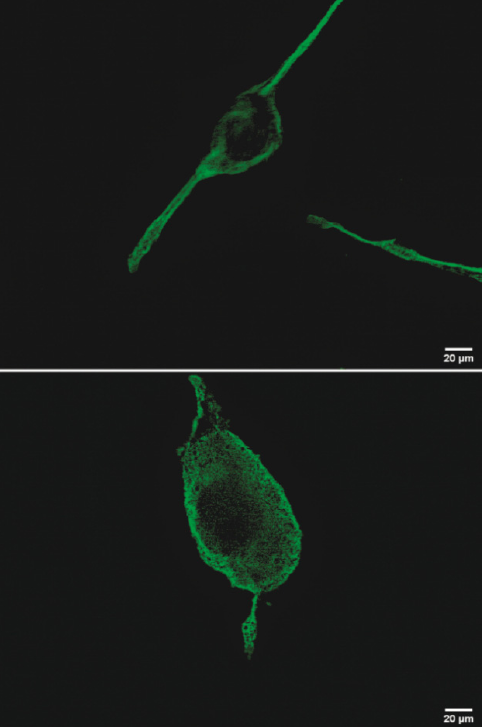
Figure 4. Upper panel, immunofluorescence of N2a cells induced neurite-like control (monomer). Lower panel, immunofluorescence of N2a cells incubated with tau aggregates alone: bars 20 µm.